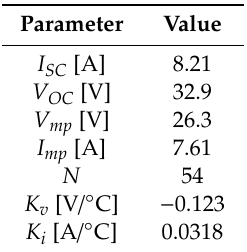
Table 1. Datasheet parameters of the Kyocera KC200GT in STC.